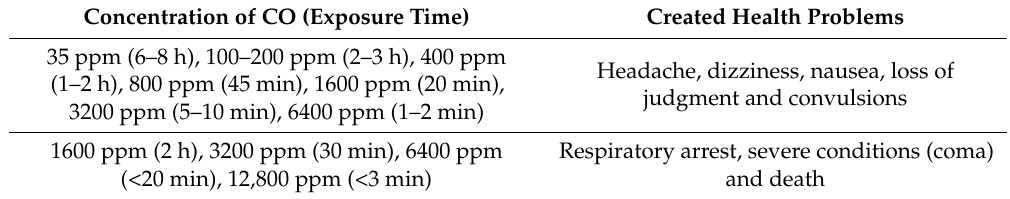
Table 1. Health problems according to carbon monoxide (CO) concentration and exposure time.